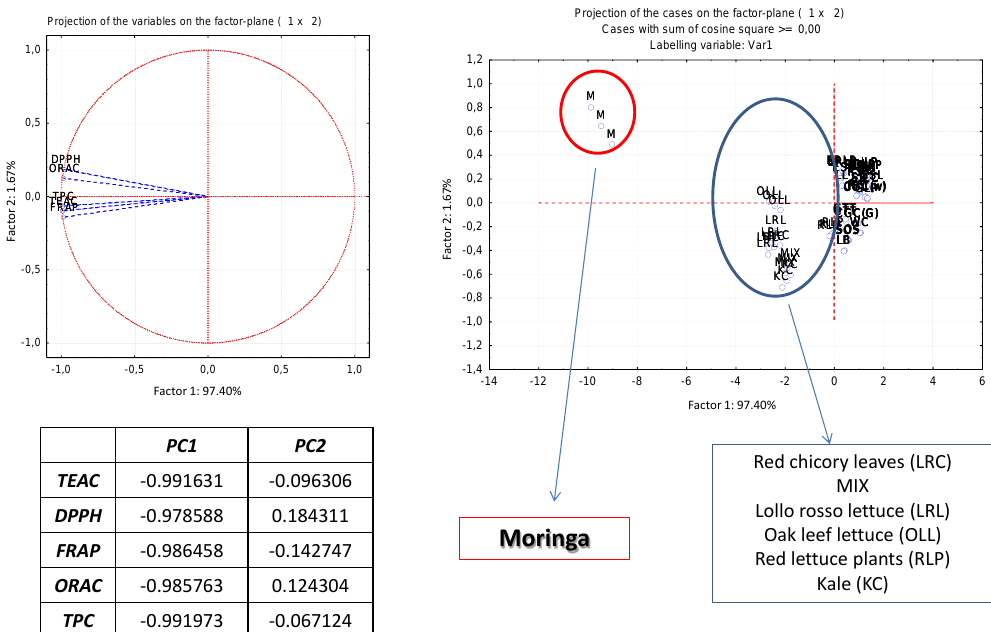
Figure 2. Loadings ( left ) and Scores ( right ) for plots obtained by principal component analysis of hydrophilic + lipophilic extract from the vegetable